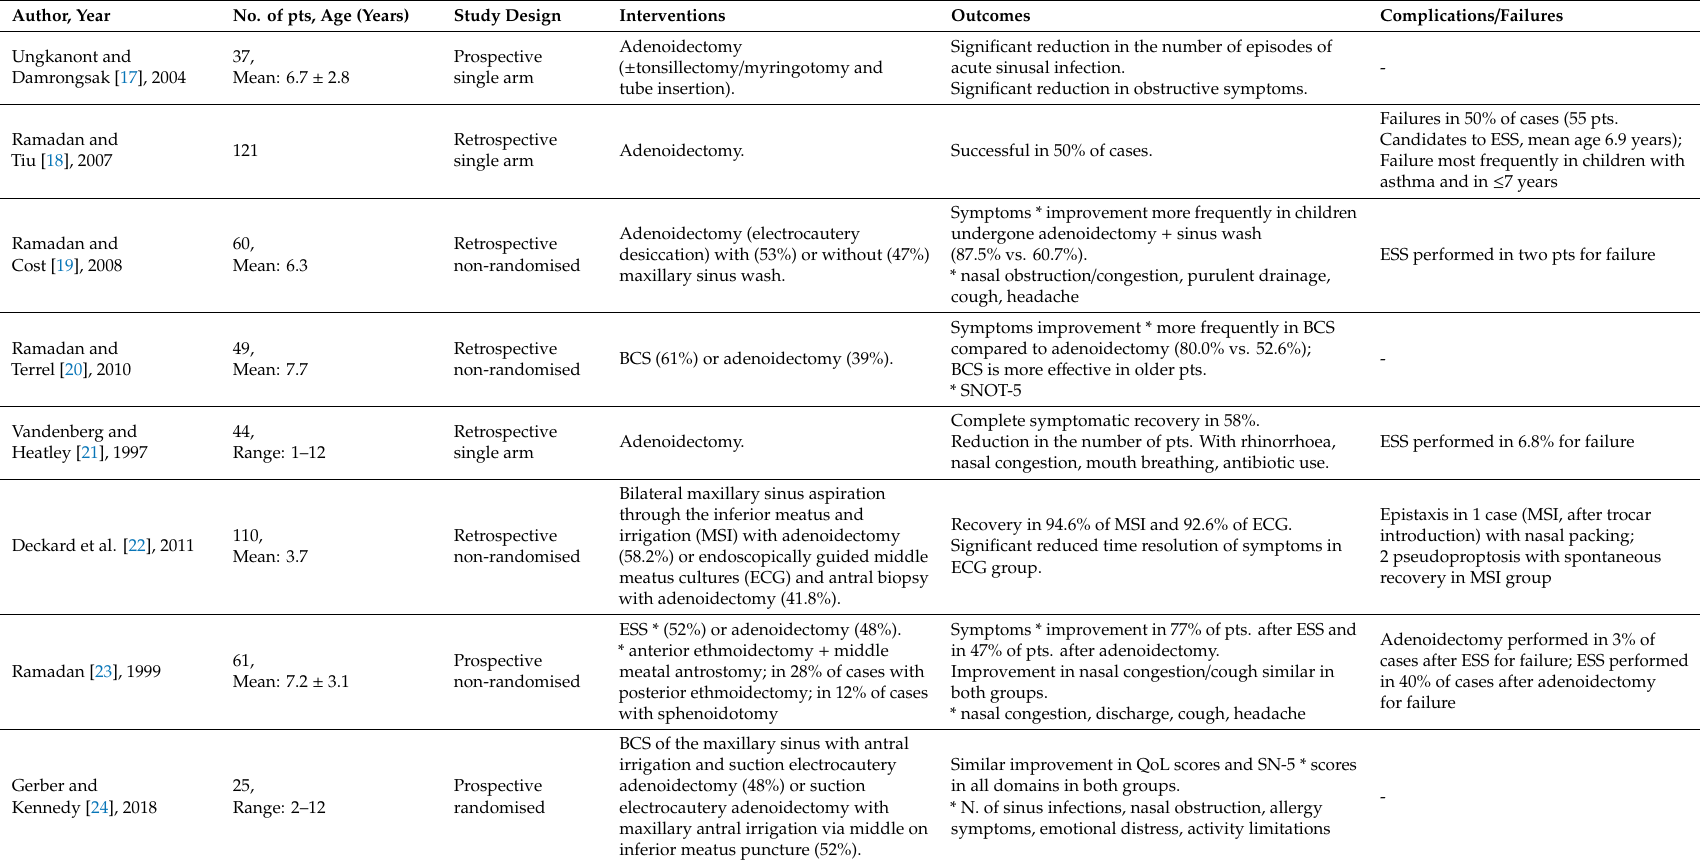
Table 1. Results of the included